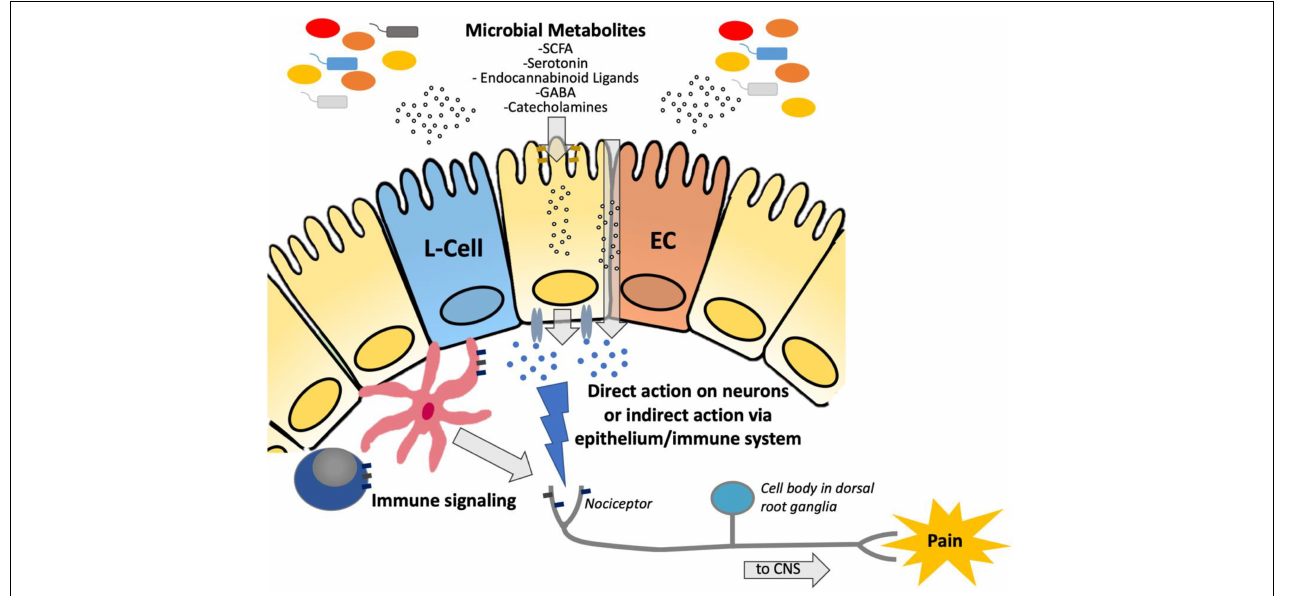
FIGURE 1 | Diagram demonstrating the suggested pathway by which microbiota-derived metabolites are transferred across the epithelium to either (a) directly interact with nociceptors to modulate hypersensitivity or (b) indirectly act via immune stimulation to modulate hypersensitivity. SCFA, short chain fatty acids; GABA, Gamma-aminobutyric acid; ECC, enterochromaffin cell; CNS, central nervous